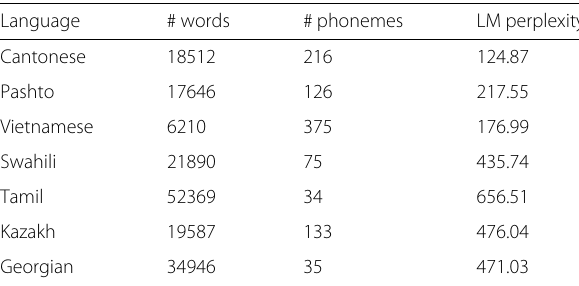
Table 2 The baseline configuration of all languages, including vocabulary size, number of phonemes, and language model